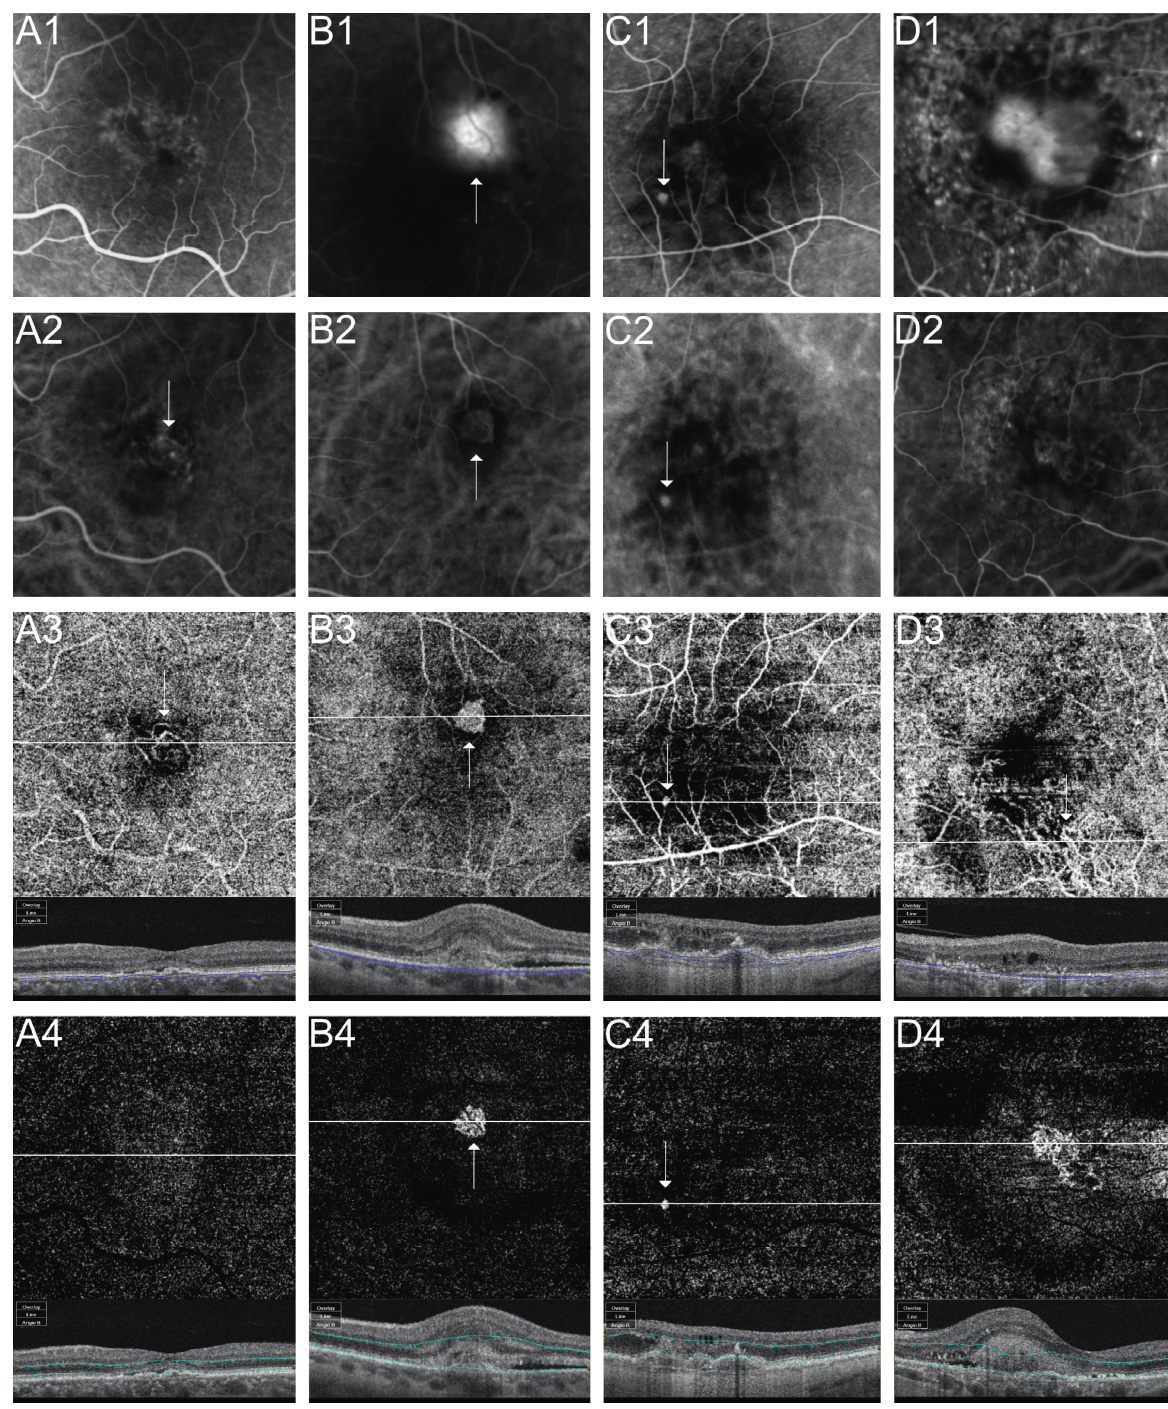
Figure 1: Detection of macular neovascularization (MNV) in age-related macular degeneration (AMD) by fluorescein angiography (FA), indocyanine green angiography (ICGA), and 4.5 × 4.5mm en-face swept source; optical coherence tomography angiography (SS-OCTA). (A1) Type 1 MNV with speckled hyperfluorescence in FA (A2) ICGA visualized the neovascular lesion (arrow). (A3) Evidence of MNV (arrow) in en-face SS-OCTA with choriocapillaris (CC) segmentation under the retinal pigment epithelium (RPE) but (A4) absence of flow in the outer retina (OR) slab. (B1) Leakage in FA consistent with a type 2 MNV (arrow) in a left eye. (B2) Early ICGA highlighted a well demarcated MNV (arrow). (B3) Automated en-face SS-OCTA CC scan with a dense MNV (arrow) surrounded by a dark halo and projection artifacts of the superficial retinal vessels. (B4) Automated en-face SS-OCTA OR segmentation with the same neovascular complex in an otherwise nonvascularized tissue. (C1) A hyperfluorescent spot (arrow) in early FA and (C2) late ICGA diagnosed as type 3 MNV. (C3) Evidence of a neovascularization in the en-face SS-OCTA with CC and (C4) OR segmentation. (D1) Mixed type MNV with early leakage surrounded by speckled hyperfluorescence in FA (D2) ICGA with a neovascular lesion. (D3) MNV presence (circle) under the RPE in the en-face SS-OCTA CC slab and (D4) clear evidence of MNV over the RPE in the OR